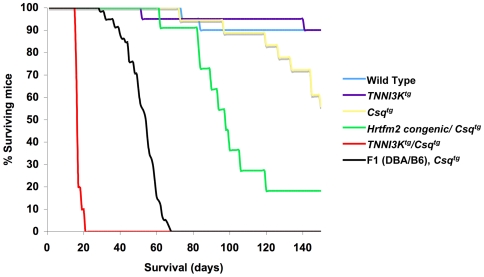
TNNI3K expression leads to premature death in the Csq transgenic model of cardiomyopathy.A Kaplan-Meier survival graph shows the outcomes of different genotypic groups resulting from a cross between TNNI3Ktg and Csqtg transgenic animals. Survival is severely decreased for double positive transgenics (TNNI3Ktg/Csqtg) to an average of 17 days with a range from 15 to 21 days. Csqtg mice on congenic background (DBA. AKR-Hrtfm2 : DBA genome except Hrtfm2 loci) survived to 107 days on average. Nearly all mice with other genotypes, including both single positives (TNNI3Ktg and Csqtg) survived to at least 150 days, at which point the animals were sacrificed and the experiment terminated. Survival of TNNI3Ktg/Csqtg and Congenic/Csqtg compared to the three other groups was significantly decreased (p<0.00001). F1(DBA/B6) Csqtg animals died much sooner (average only 50 days) when compared to Csqtg in the background of the isolated (congenic) Hrtmf2 locus. The number of animals in each group is as follows: Wild type, n = 18; TNNI3Ktg, n = 18; Csqtg, n = 18; Congenic/Csqtg, n = 11; TNNI3Ktg/Csqtg, n = 12, F1(DBA/B6) Csqtg, n = 58 (F1 data from [5]).